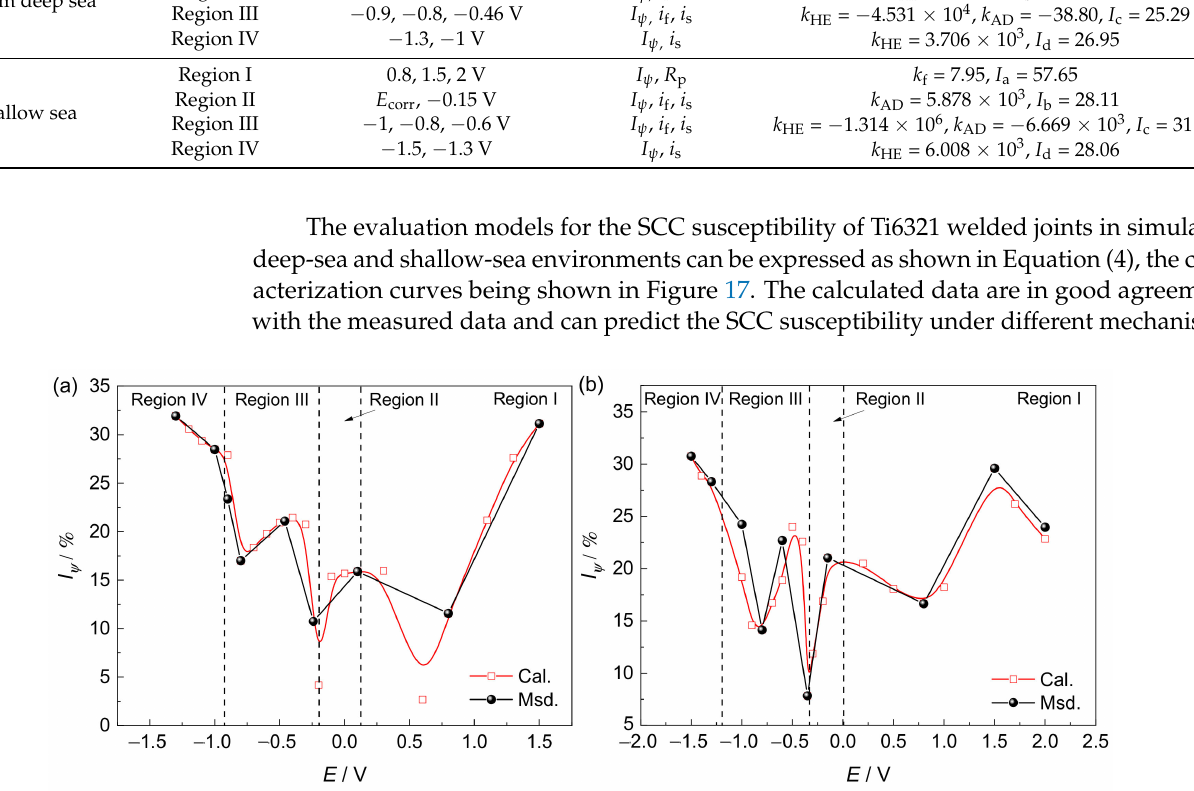
Figure 17. Characterization of stress corrosion cracking susceptibility using the evaluation models in simulated deep − sea ( a ) and shallow − sea ( b )